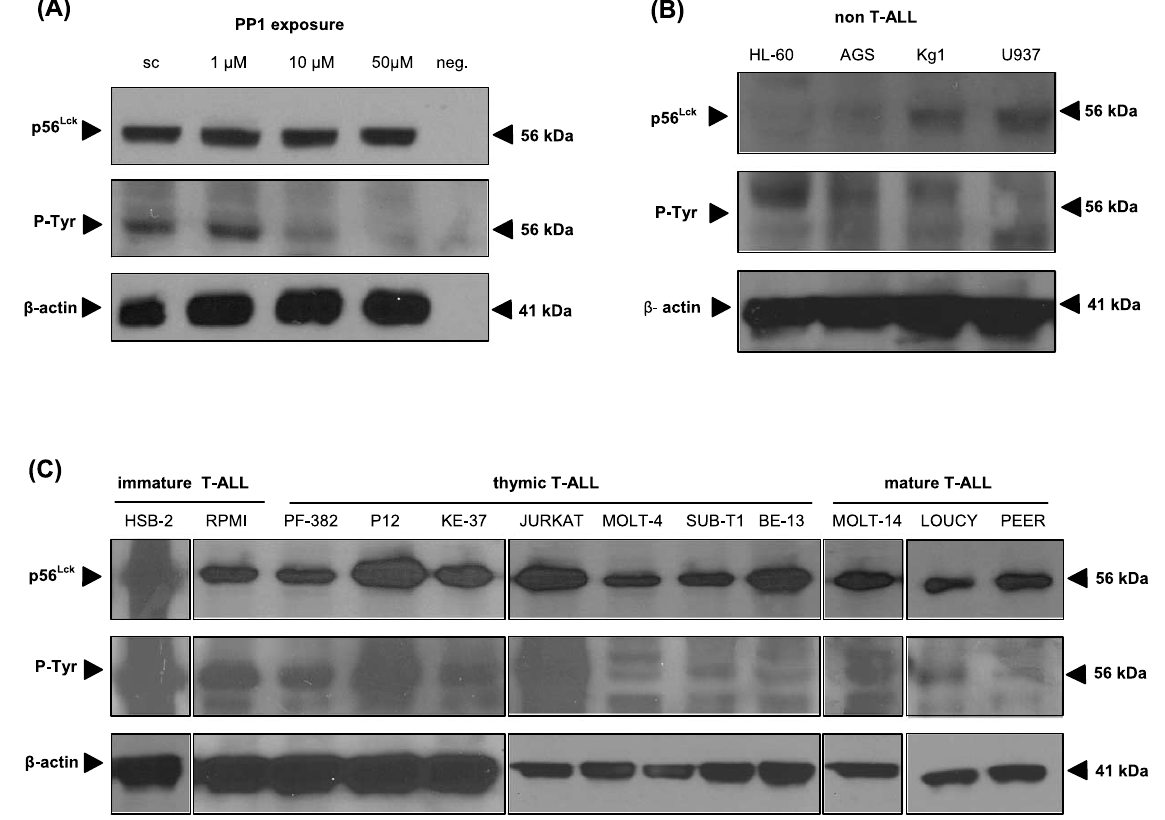
Fig. 2. Western blot analysis of p56 Lck protein expression, total cellular tyrosine phosphorylated proteins (P-Tyr) and β -actin in human leukemic cell lines. (A) The human T-ALL cell line JURKAT (1 × 10 6 cells) was incubated either with the control (0.02% DMSO) or with PP1 at the respective concentrations (neg. – no protein control). After 48 h incubation equal cell lysate amounts (1.5 × 10 5 cells) were analyzed for p56 Lck protein expression (56 kDa), P-Tyr status and β -actin (41 kDa) by Western blotting as described in Section 2. (B, C) Equal cell lysate amounts (3 × 10 5 cells) of human non-T-ALL cell lines (B) and human T-ALL cell lines (C) were analyzed for the expression of p56 Lck (56 kDa), tyrosine phosphorylated proteins and β -actin (41 kDa). Abbreviations: sc = solvent control, RPMI = RPMI-8402, P12 =